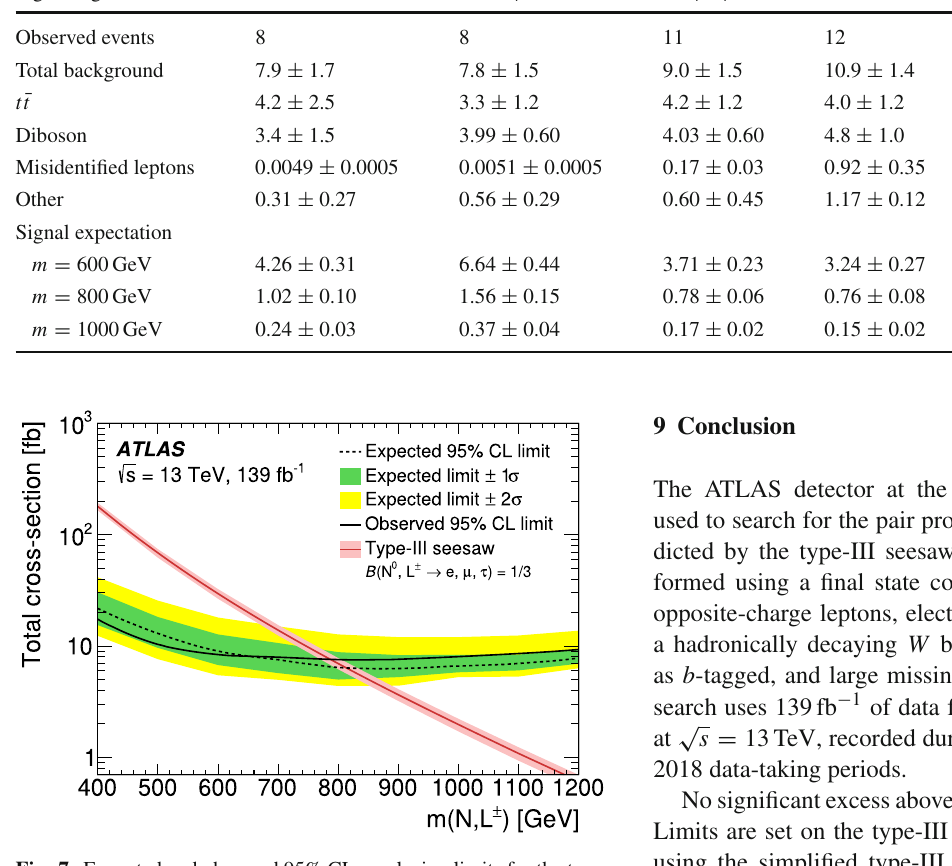
Fig. 7 Expected and observed 95% CL s exclusion limits for the type- III seesaw process with the corresponding one- and two-standard- deviation bands, showing the 95% CL upper limit on the cross-section. Thetheoreticalsignalcross-sectionprediction,givenbytheNLOcalcu- lation [26,27], is shown as a red line with the corresponding uncertainty